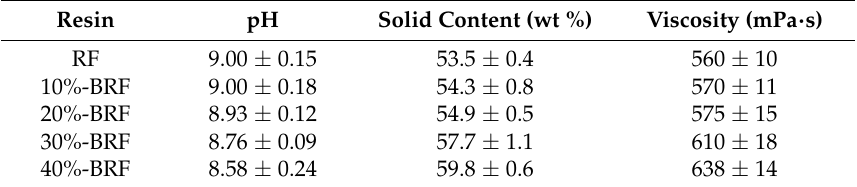
Table 1. Properties of resorcinol-formaldehyde (RF) and bio-oil-resorcinol-aldehyde (BRF) resins.